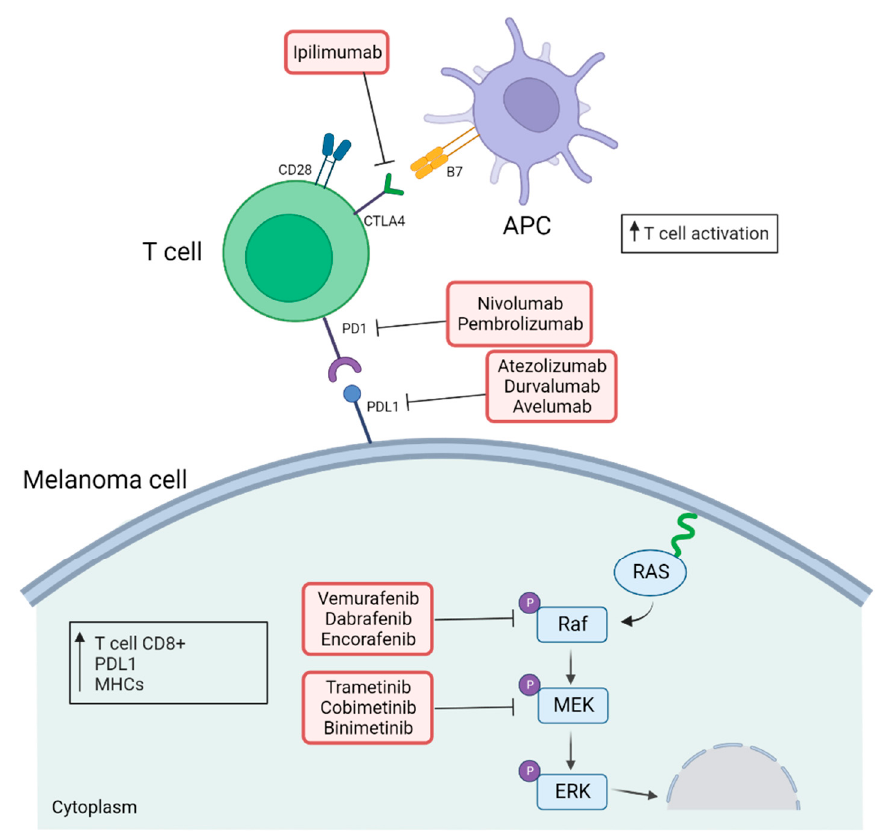
Figure 3. Effects of combination of immune checkpoint inhibitors and RAS–ERK pathway-targeted drugs. Representation of the effect of anti-CTLA4 and anti-PD1/PDL1 antibodies along with inhibitors of the RAS–ERK pathway to treat patients with metastatic melanoma (created with BioRender; www. biorender.com, access date: 20 October